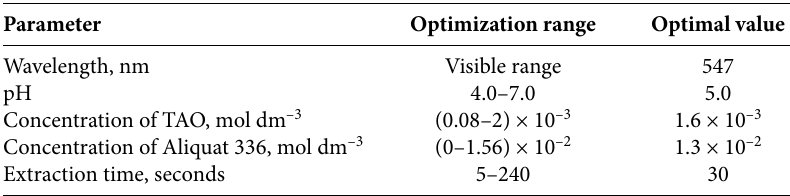
Table 1. LLE-spectrophotometric optimization of the V V – TAO – Aliquat 336 – water – isobu- tanol